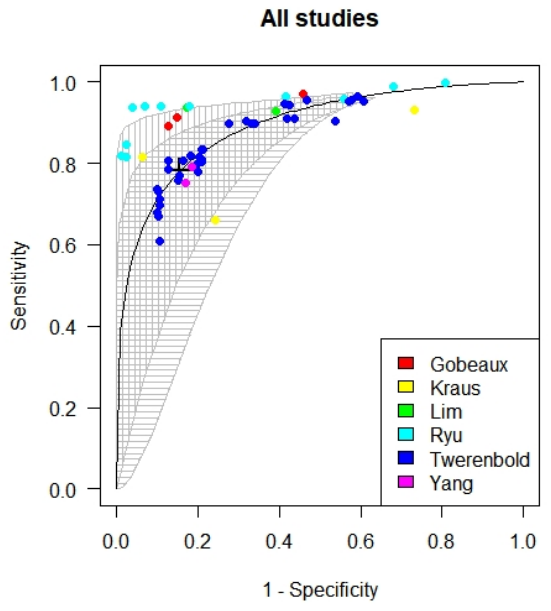
Figure 4. SROC curve for the optimized troponin cut-off in patients with chronic kidney disease. For patients with eGFR < 60 mL/min/1.73 m 2 not on dialysis, the optimized cut-off for